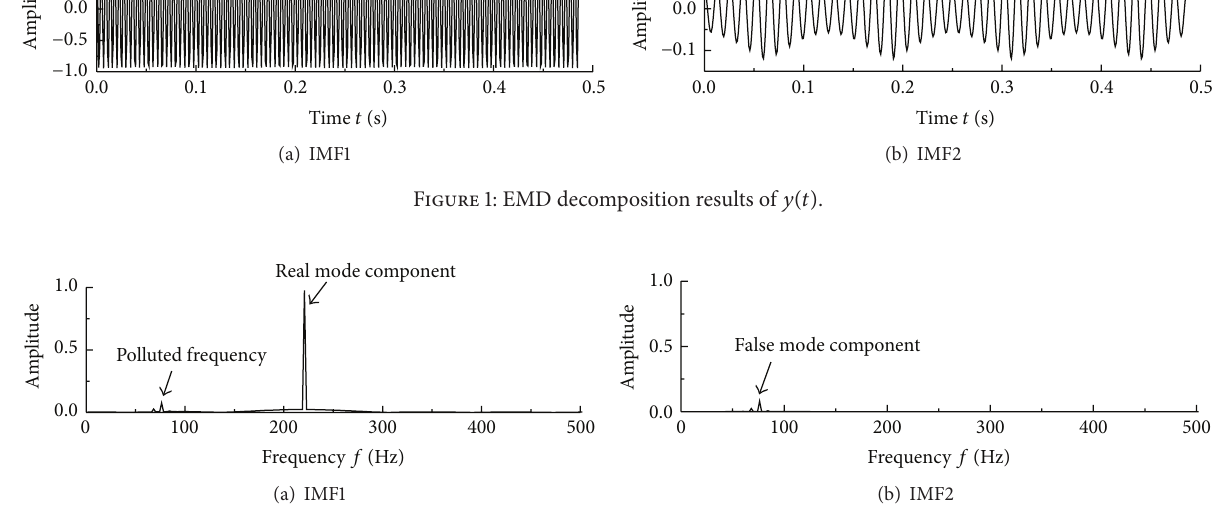
Figure 2: FFT spectrum of the signal presented in Figure